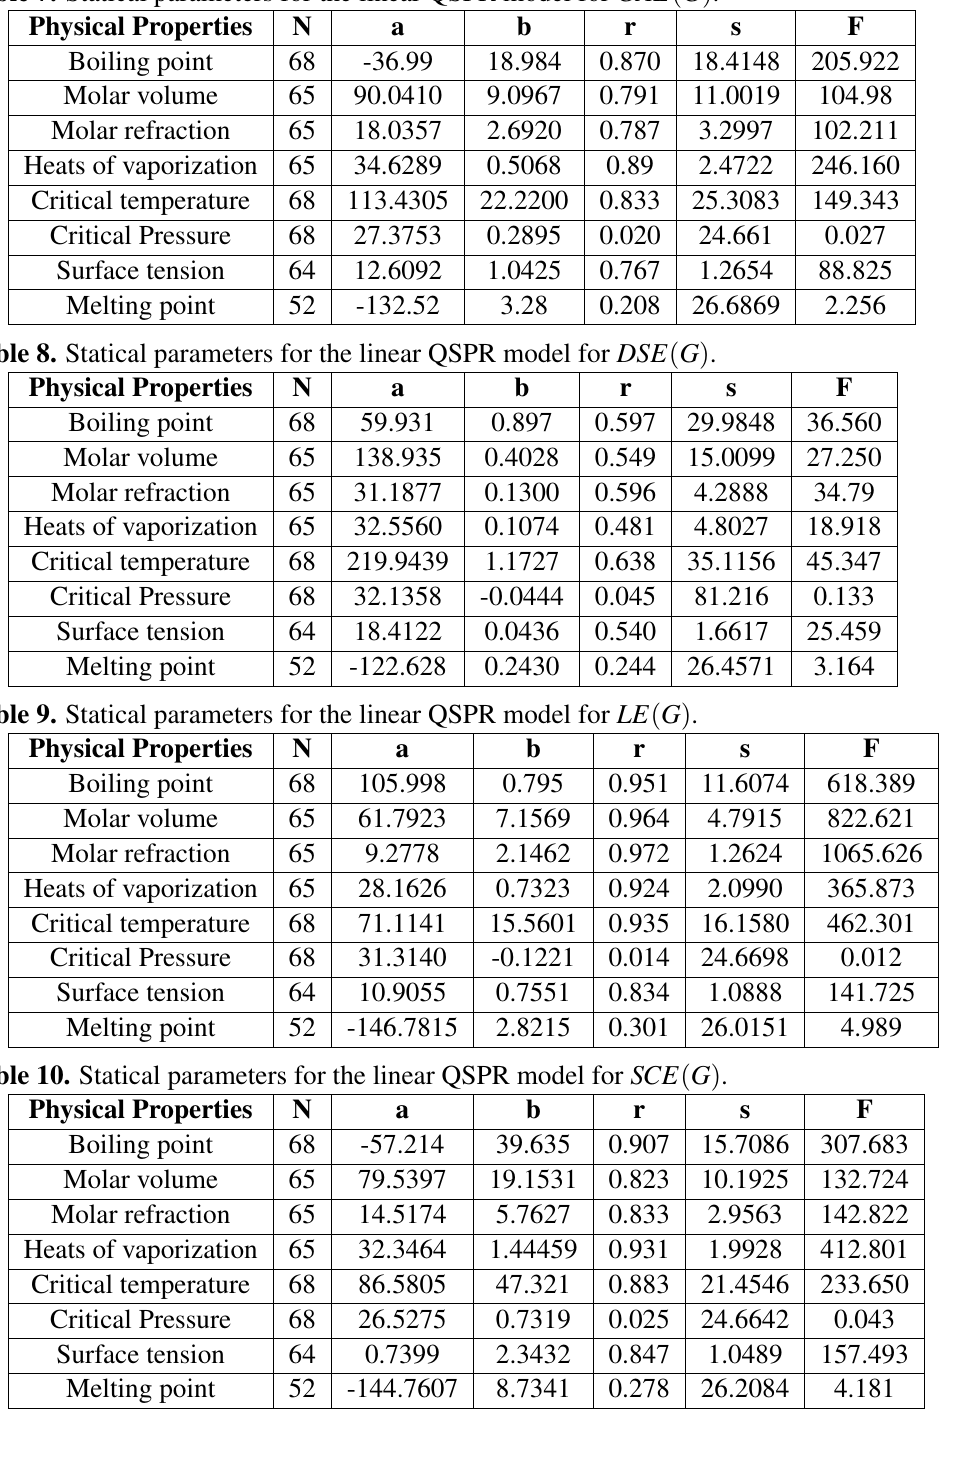
Table 7. Statical parameters for the linear QSPR model for GAE ( G ) .